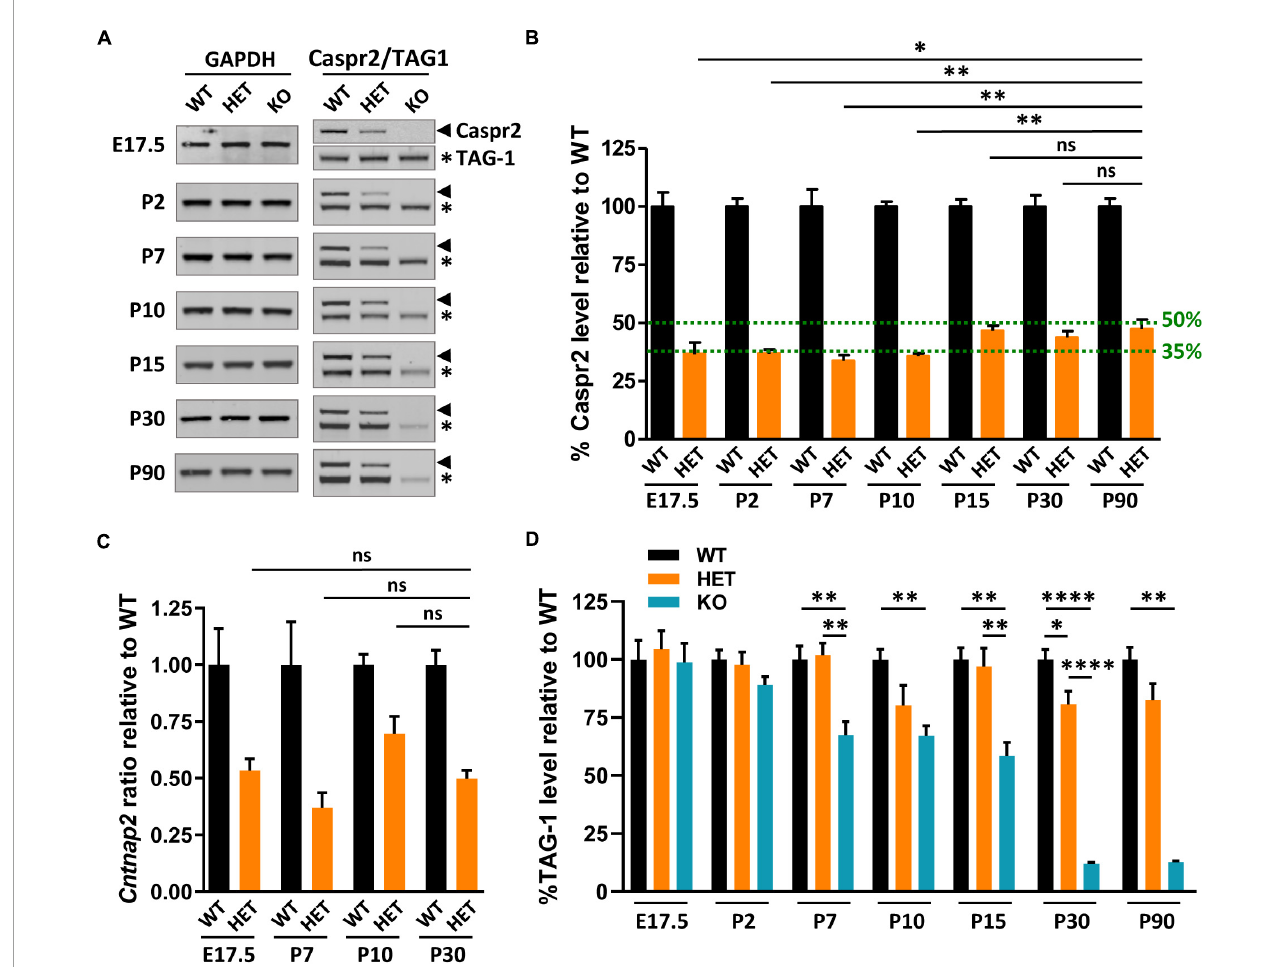
FIGURE8 Caspr2, TAG-1, and Cntnap2 mRNA levels in mouse brains during development. Representative immunoblots showing Caspr2, TAG-1, and GAPDH levels in brain lysates of wild-type (WT), HET, and KO mice at different developmental stages and at adulthood (A) . Levels of Caspr2 normalized to GAPDH levels and relative to mean WT (in %) (B) . Levels of Cntnap2 mRNAs normalized to the Psap gene and relative to mean WT (ratio) in brain of WT, HET, and KO mice at E17.5, P7, P10, and P30 (C) . Levels of TAG-1 normalized to GAPDH levels and relative to mean WT (in %) (D) . (B–D) Six